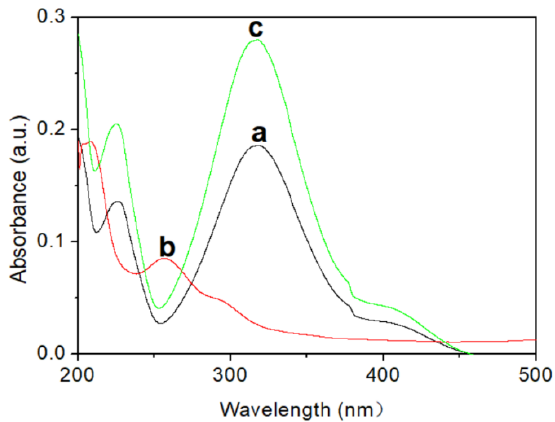
Figure 3. UV–vis absorption spectra of (a) 4-nitrophenol, (b) 4-NP-loaded aptamer/cDNA-MMSNs and (c) the supernatant after 4-NP-loaded aptamer/cDNA-MMSNs reacted with 1.0 ng mL −1 of CEA.